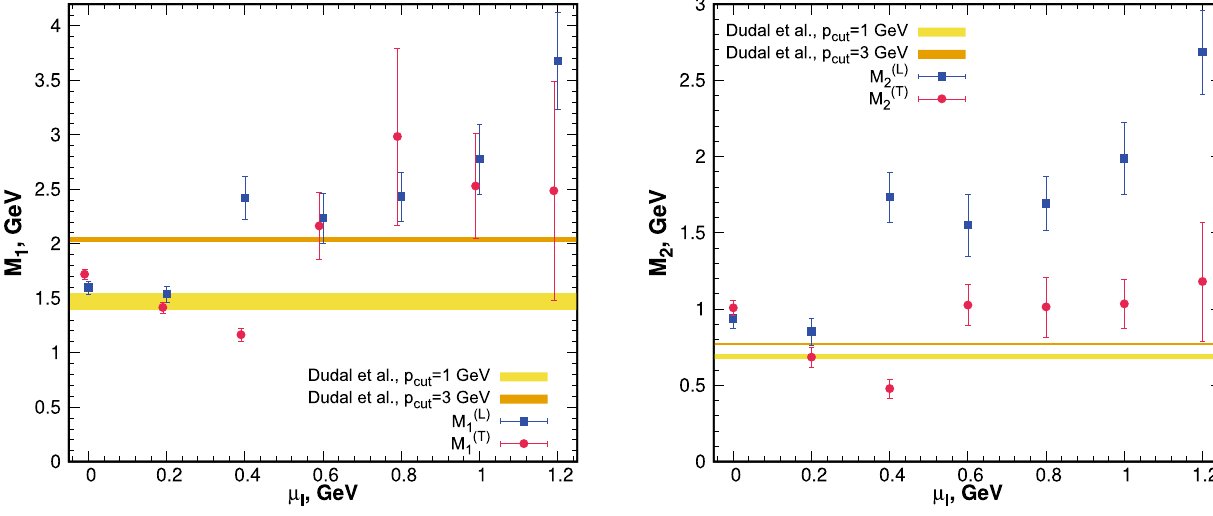
Fig. 5 Parameters M 1 (left) and M 2 (right) of the fit (23) as functions of μ I . Yellow strips show the results obtained in [55] with p cut = 1 GeV, brown strips – with p cut = 3